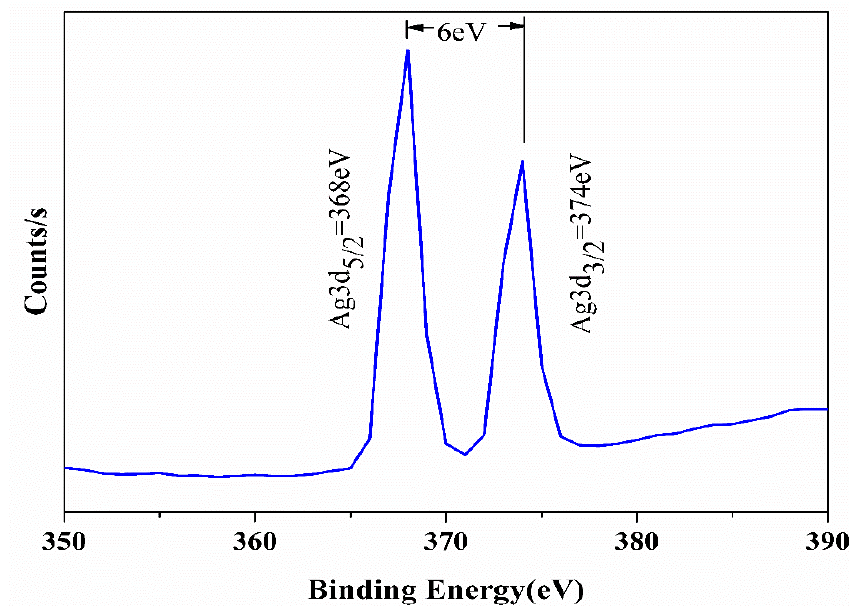
Figure 7. Ag3d XPS peak of DBD-CS-Ag NPs treated PLA nonwoven